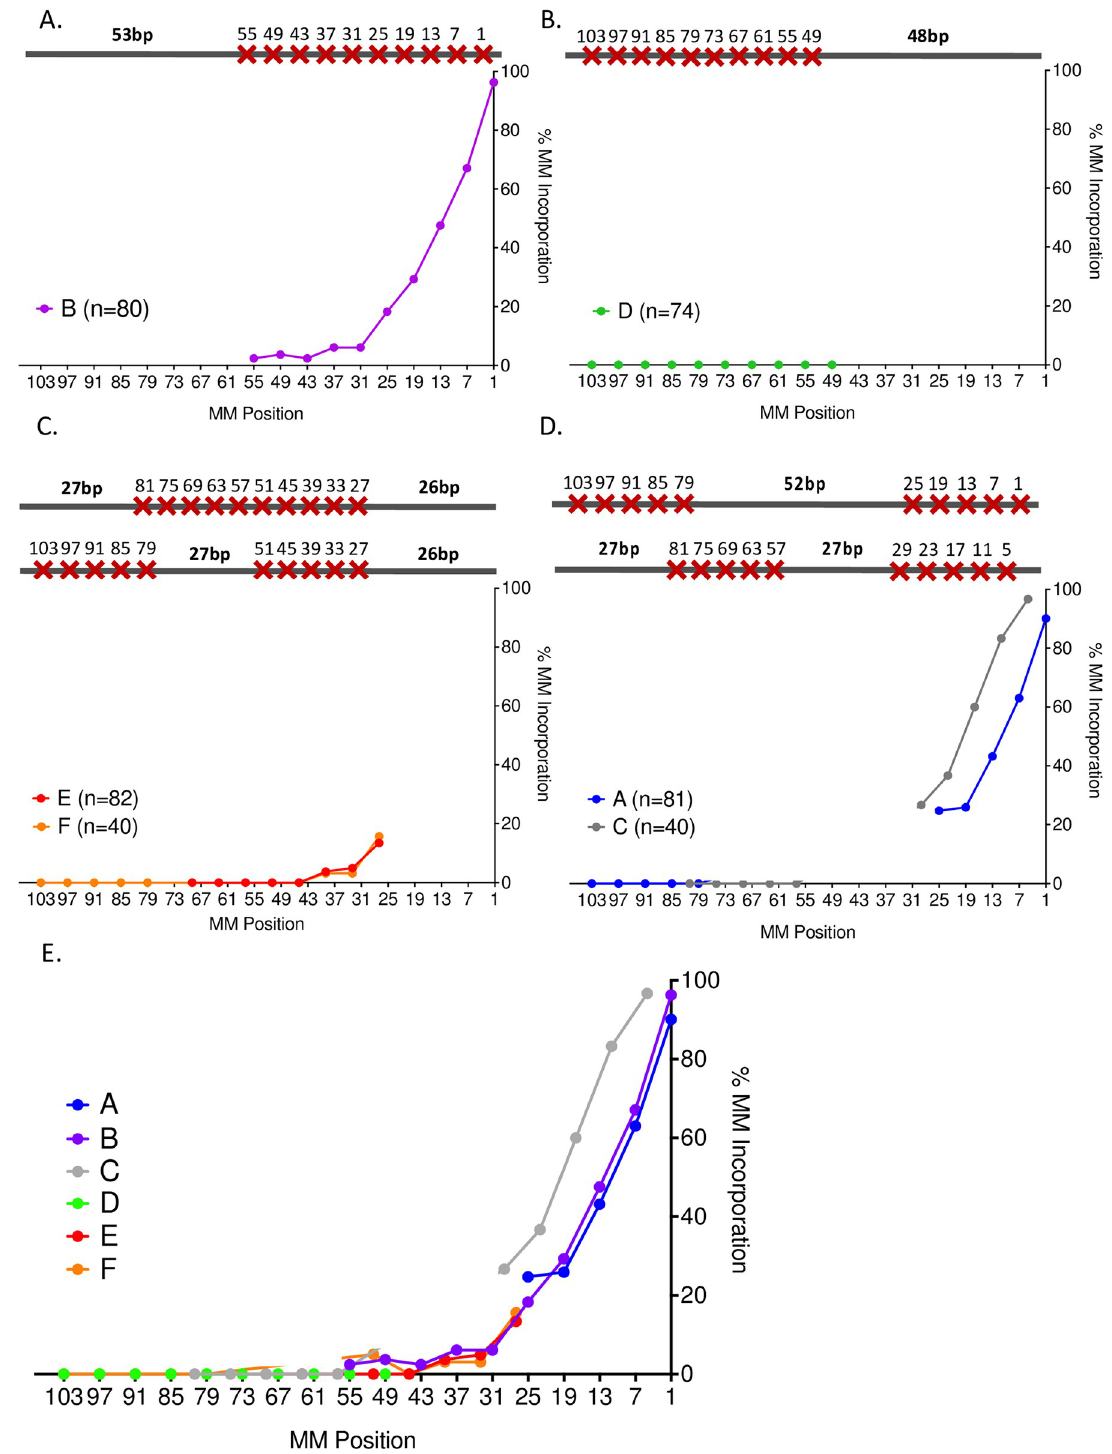
Fig 5. Incorporation of mismatches into the BIR product. A-D. Percent mismatch incorporation of individual donor templates containing 10 mismatches distributed unevenly throughout the 108-bp donor template. The number of sequenced recombinant clones for each template are indicated. E. Composite of % mismatch corrections for 6 different templates with different distributions of 10 mismatches.